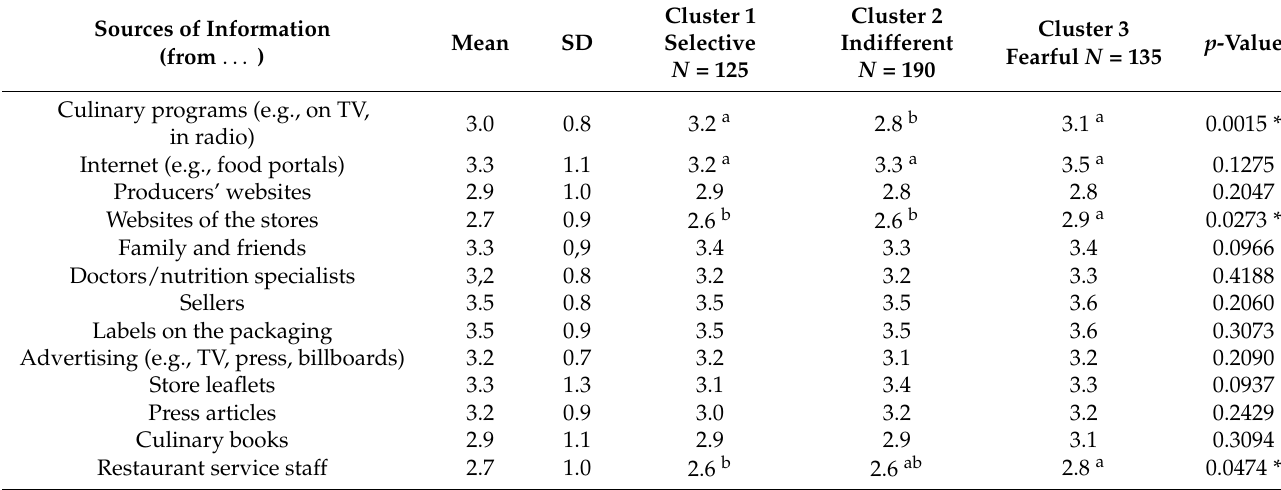
Table 5. Cluster profiles according to the participants’ opinions on using the sources of information about the game meat (mean value ± SD *; N = 450,